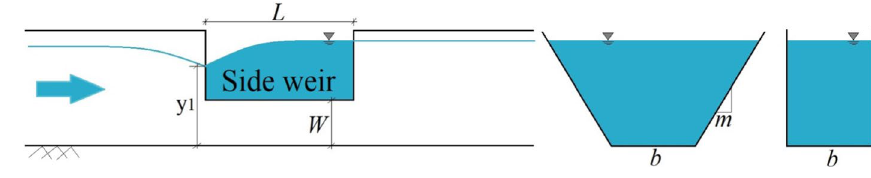
Table 1 Maximum, minimum, and average values of the applied experimental measurements